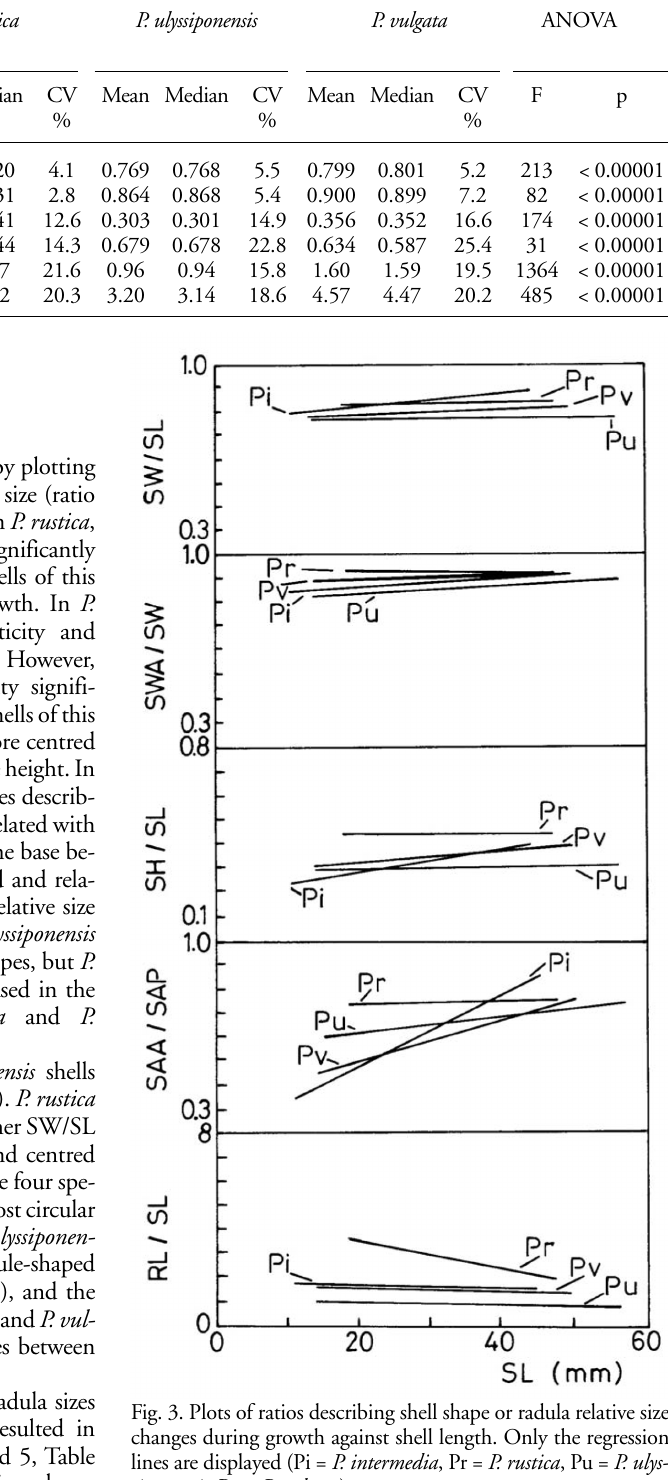
Table 2. Descriptive statistics for the variables describing shell shape and radula relative size. P. intermedia